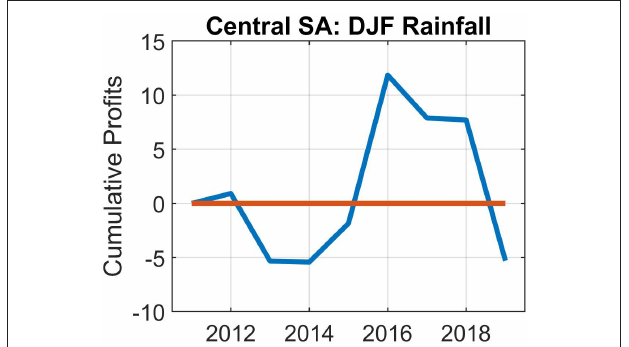
FIGURE 8 | As for Figure 6 , but for 13-years and for Nov-Dec-Jan rainfall forecasts for the second farm located in the northwestern interior of South Africa.